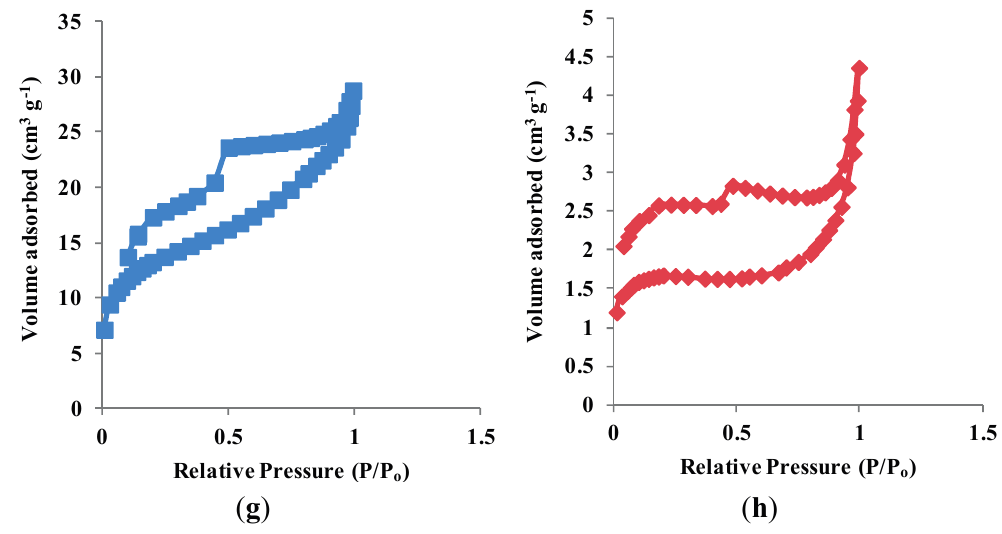
Figure 7. The N 2 adsorption-desorption isotherms for ( a ) RAFT-MIP1; ( b ) RAFT-NIP1; ( c ) MIP1; ( d ) NIP1; ( e ) RAFT-MIP2; ( f ) RAFT-NIP2; ( g ) MIP2; and ( h )